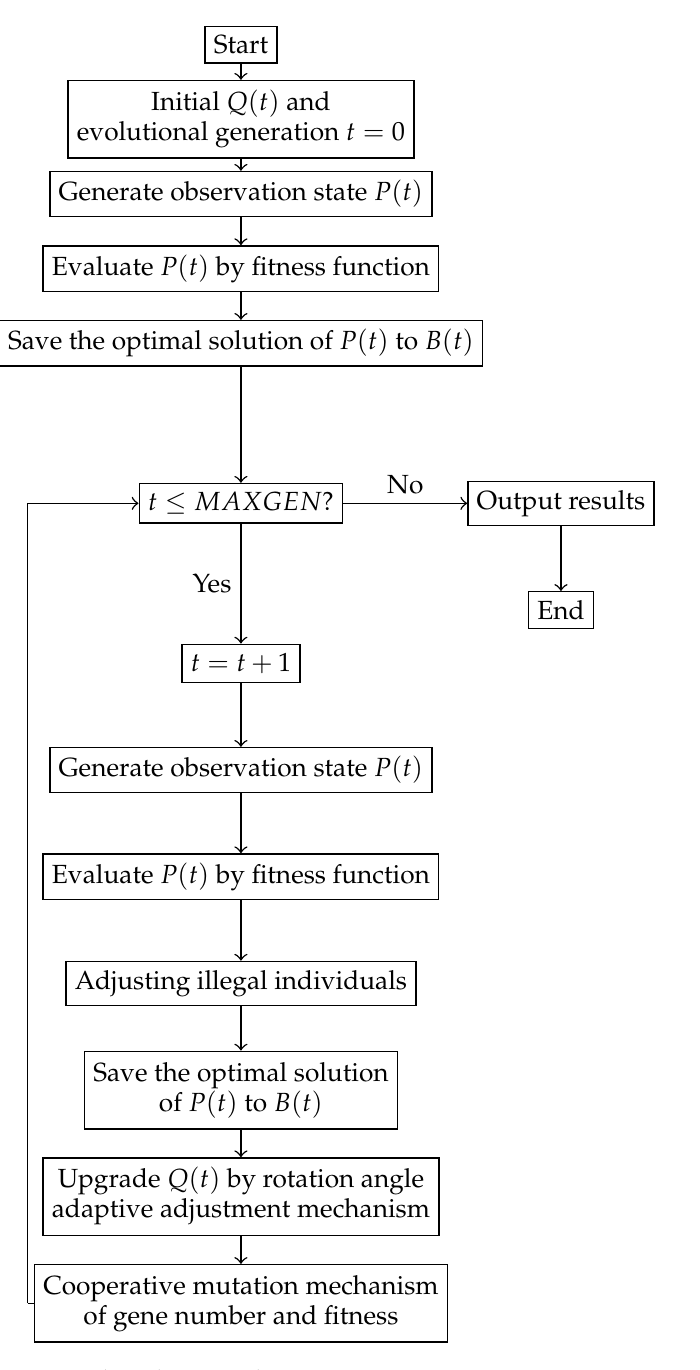
Figure 4. Algorithm precedure.